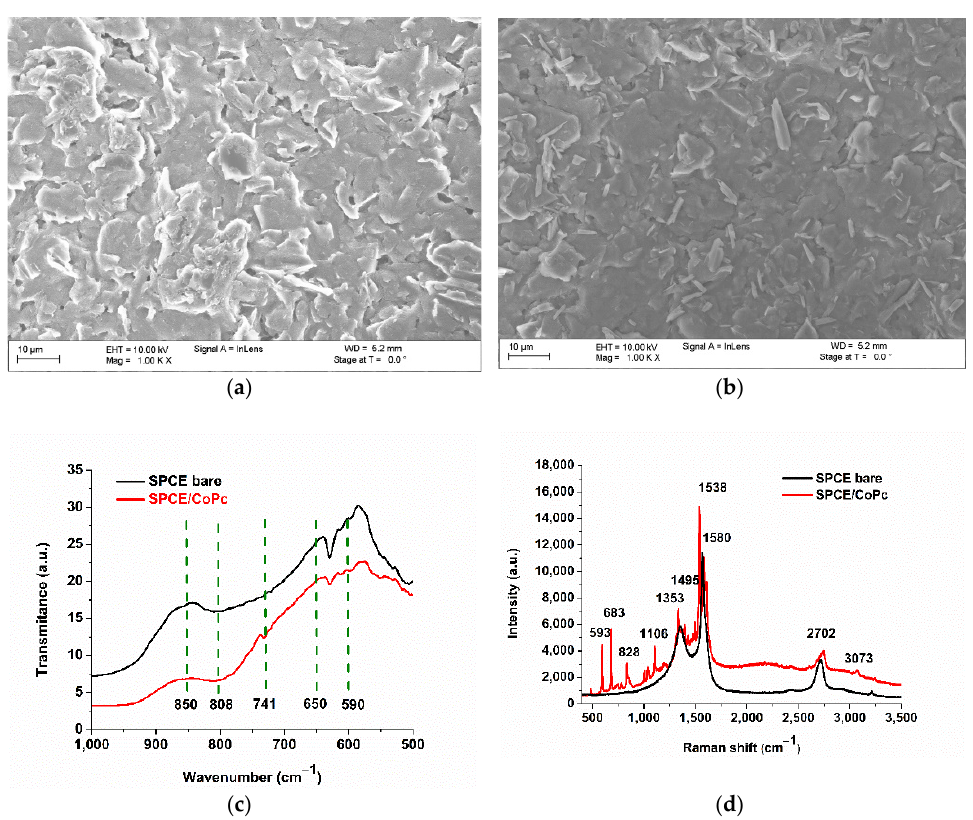
Figure 2 . SEM characterization of the ( a ) unmodified SPCE and ( b ) SPCE/CoPc, ( c ) FTIR spectra of unmodified SPCE and modified SPCE with CoPc (SPCE/CoPc) [1] , ( d ) Raman spectra of unmodi- unmodified SPCE and modified SPCE with CoPc (SPCE/CoPc) [1], ( d ) Raman spectra of unmodified fied and CoPc modified SPCE. and CoPc modified